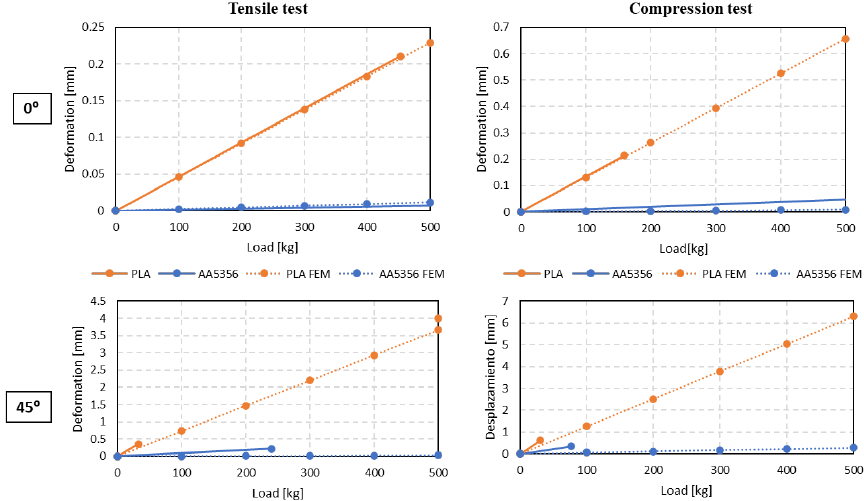
Figure 13. Deformation at different loadings under tensile and compression tests compared with the FEM results oriented at 0° and 45° on PLA and AA5356 turrets. It is clear from the graph that, at 0° deformation under tensile and compression tests, both materials are close to the admissible limit. At 45°, deformation is larger in both ma- terials. So, it is concluded that the parts built from additive manufacturing go under a higher deformation when the load is applied at 45°, which is due to the anisotropy of the material in the different directions, and it is clearly captured by the FEM simulation re- sults. This comparison between the FEM and experimental tests shows that FEM model allow us to understand the behavior of the mechanical properties of different materials. This kind of validation helps the designer to choose the different additive manufacturing